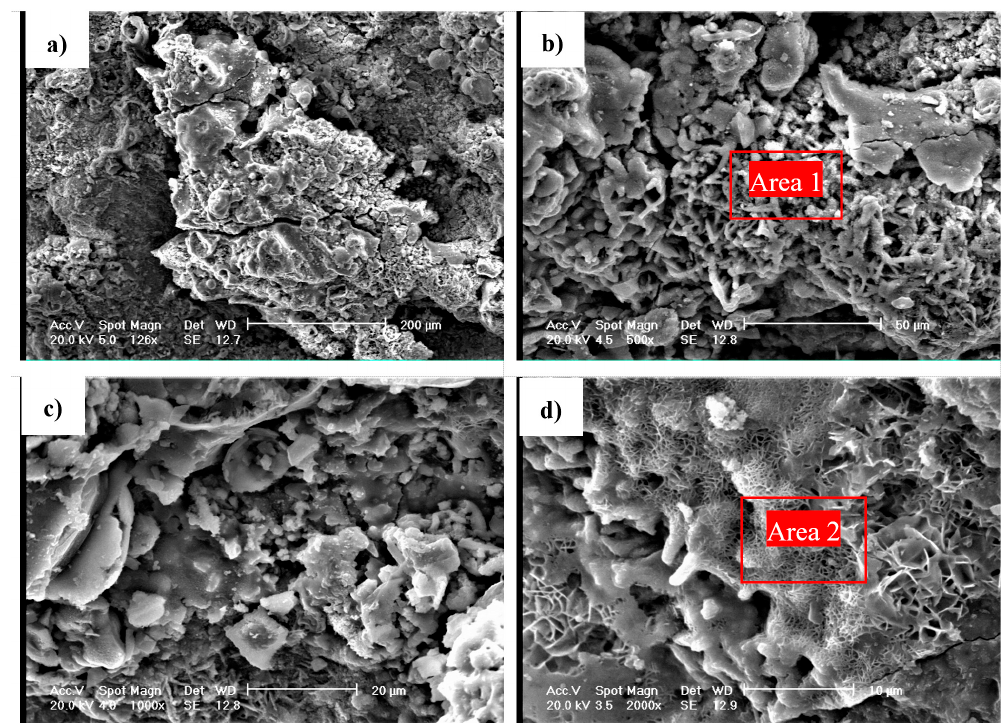
Figure 9. Different morphologies of the corrosion products at the inner surface: ( a ) and ( b ) scale-like layer intermingled with some globular α -FeOOH particles, ( c ) plate-like micaceous crystalline features, and ( d ) honeycomb-like structures.